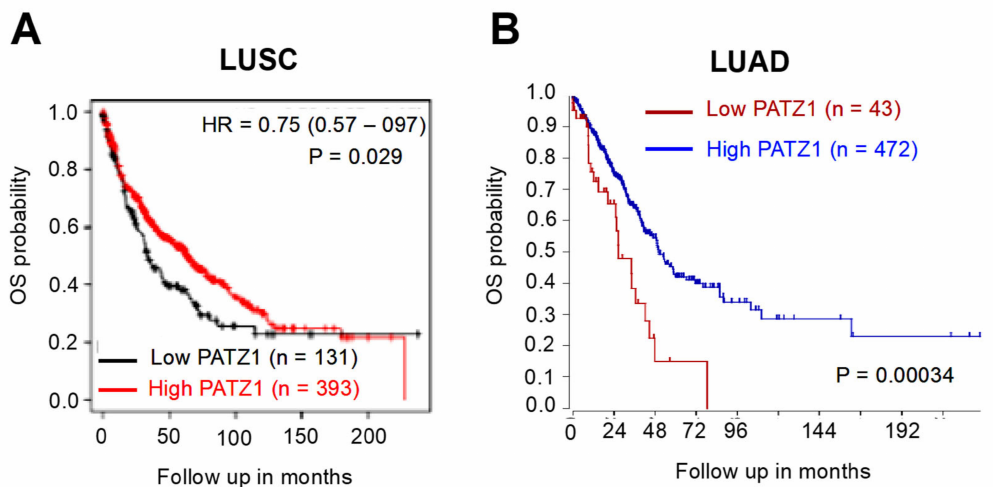
Figure 3. Low expression of PATZ1 gene is associated with a worse prognosis. ( A ) Overall survival (OS) metanalysis in LUSC based on PATZ1 expression using publicly available transcriptomic and clinical data via the Kaplan–Meier Plotter platform [33]. The expression cutoff was set to the lower quartile. ( B ) OS analysis in LUAD based on PATZ1 expression using a gene expression data subset from the TCGA via the R2: Genomic Analysis and Visualization platform [36]. The expression cutoff was set to 632 (lower sextile) according to the scan function. HR, Hazard ratio.